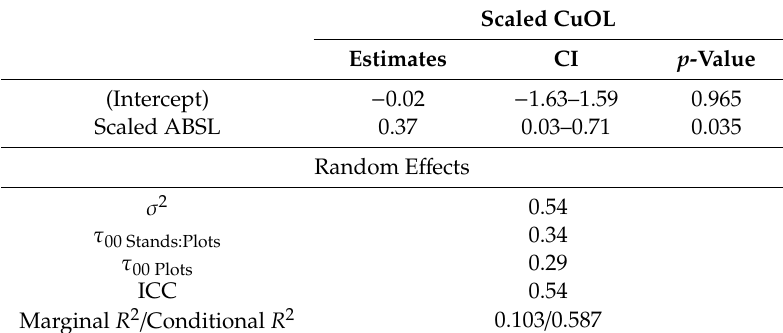
Table 1. Results from the linear mixed models (LMM) between ABSL and CuOL. All continuous variables were scaled before analysis (i.e., the mean was subtracted from each observation and the result divided by the standard deviation). The fixed part of the model reports the estimates, the confidence interval (CI), and the p-value for both intercept and slope, while the random e ff ects are reported as τ 00 Stands:Plots explained variance ( σ 2 ), random intercept variance ( τ 00 ), and intraclass correlation coe ffi cient (ICC). Goodness-of-fit is reported as marginal and conditional R 2 to account for the e ff ect of fixed and fixed + random components of the model, respectively. Scaled CuOL Estimates CI p -Value